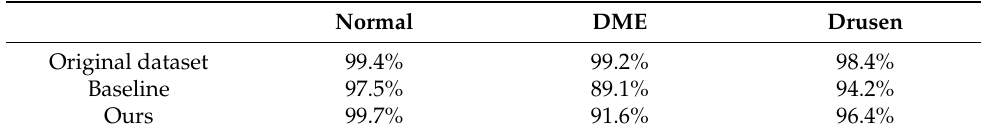
Table 1. Classification accuracy of normal, DME, and drusen using VGG16.